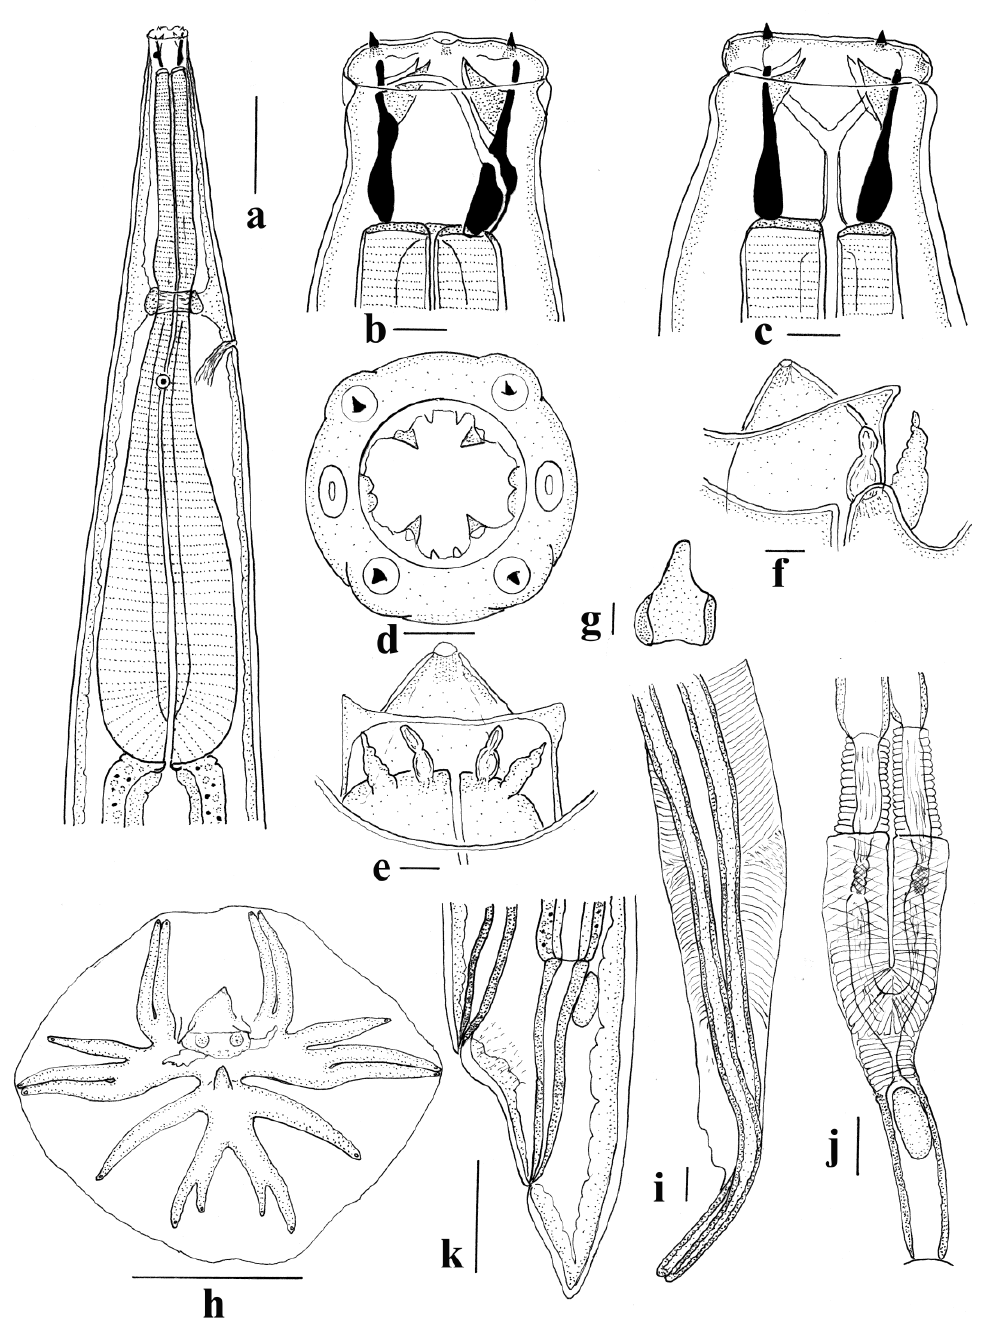
Figure 7. Macropostrongyloides phascolomys n. sp. ( a ) Anterior region, lateral view; ( b ) Buccal capsule, lateral view; ( c ) Buccal capsule, dorsal view; ( d ) Mouth, apical view; ( e ) Genital cone, dorsal view; ( f ) Genital cone, lateral view; ( g ) Gubernaculum, dorsal view; ( h ) Bursa, apical view; ( i ) Spicule tip, lateral view; ( j ) Vagina and ovejector, lateral view; ( k ) Female tail, lateral view. Scale-bars: ( a , e – h , j – k ), 0.1 mm; ( b – d , i ), 0.01